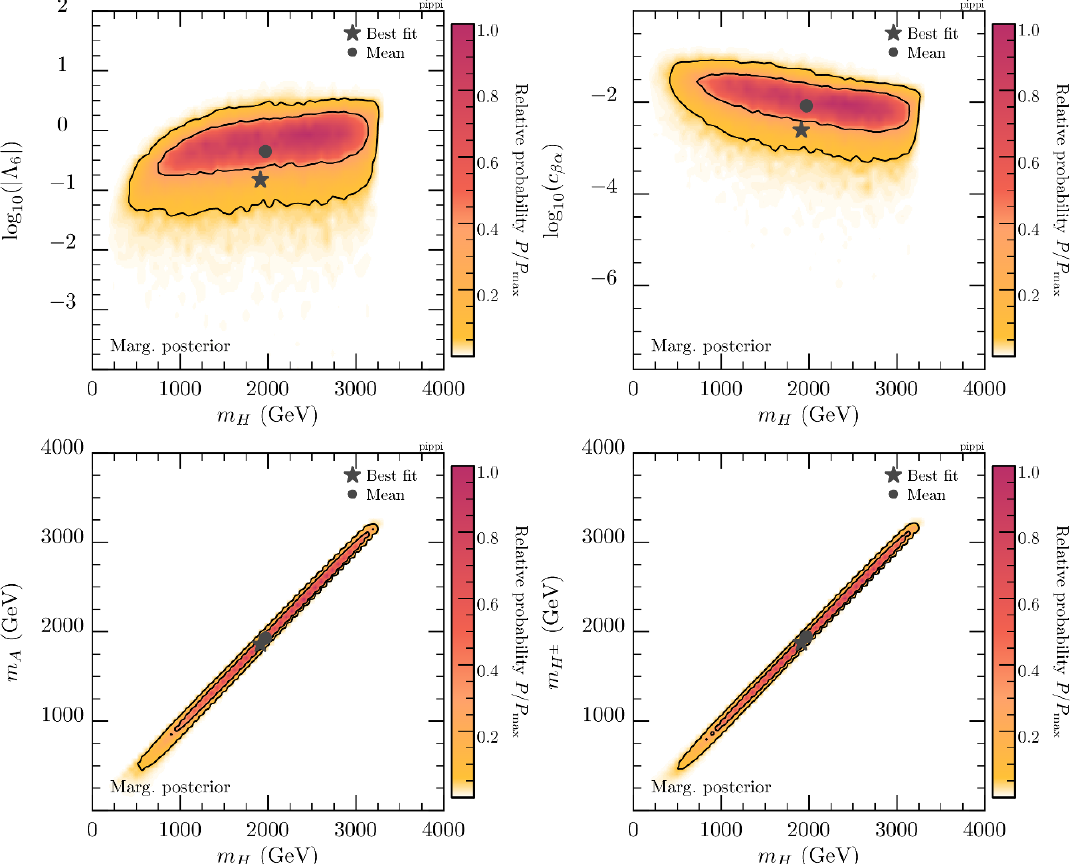
Figure 9 . Top left [right] : log between the extra scalar particles of the 2HDM, m A [ m (cid:6) regions are represented by the solid